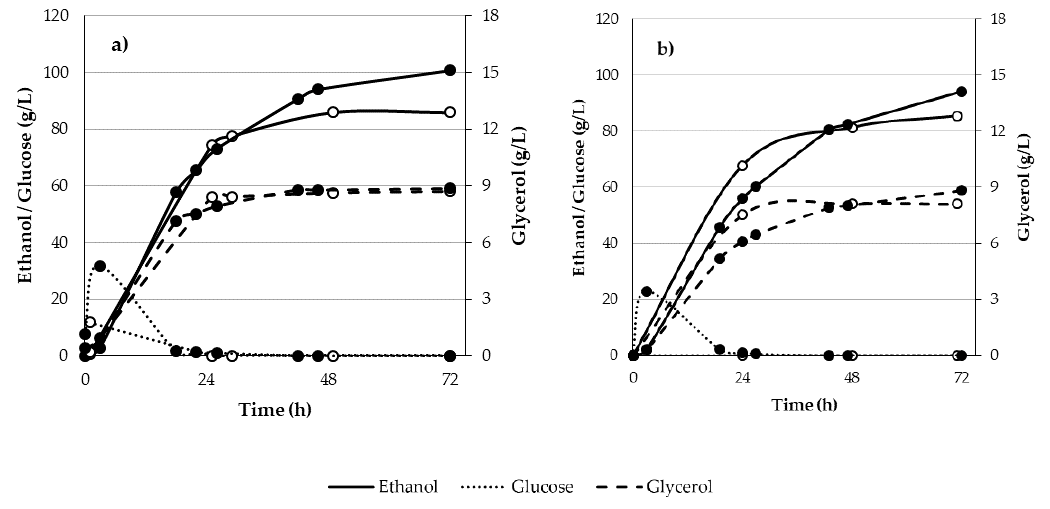
) and raw corn starch ( (cid:108) ). (cid:35)